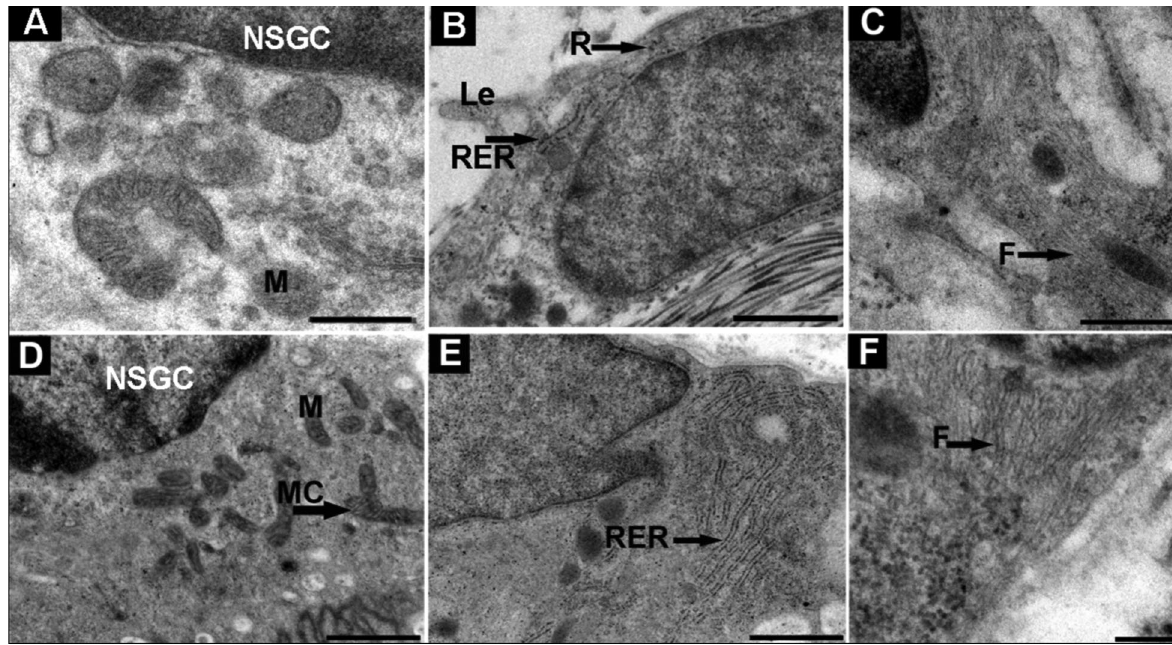
Figure 2. Cross-section of a naive ( A , B , C ) and transected ( D , E , F ) Rana catesbeiana ’s dorsal root ganglion. A , Nuclear satellite glial cells (NSGC) with chromatin condensation and heterochromatin attached to the nuclear membrane. Note mitochondria (M) with an intracristal space of normal aspect. B and C , Ribosomes (R), rough endoplasmic reticulum (RER) and intermediate filaments (F) in the cytoplasm of satellite glial cell (SGC). Note the lamellar cytoplasmic expansion (Le) emerging from SGC. D , Nucleus of SGC of normal aspect 3 days after sciatic nerve transection. Note the greater number of M ( D ), RER ( E ) and F ( F ) in SGC cytoplasm. MC = tranverse mitochondrial cristae. Scale bars: A , B , C = 0.5 m m; E and F = 1 m m; D = 0.2 m m.